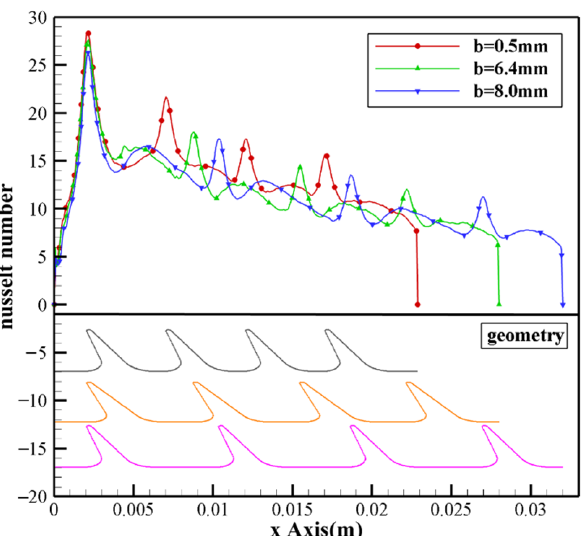
Figure 19. Nusselt number distribution of labyrinth bushing with different tooth spacing along the path.